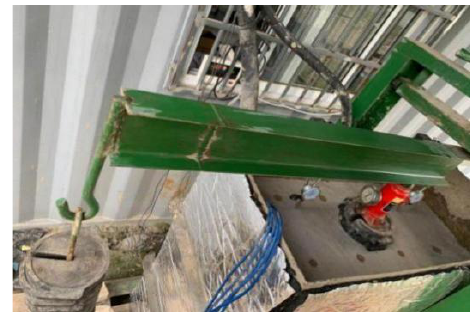
Figure 4. Loading system.